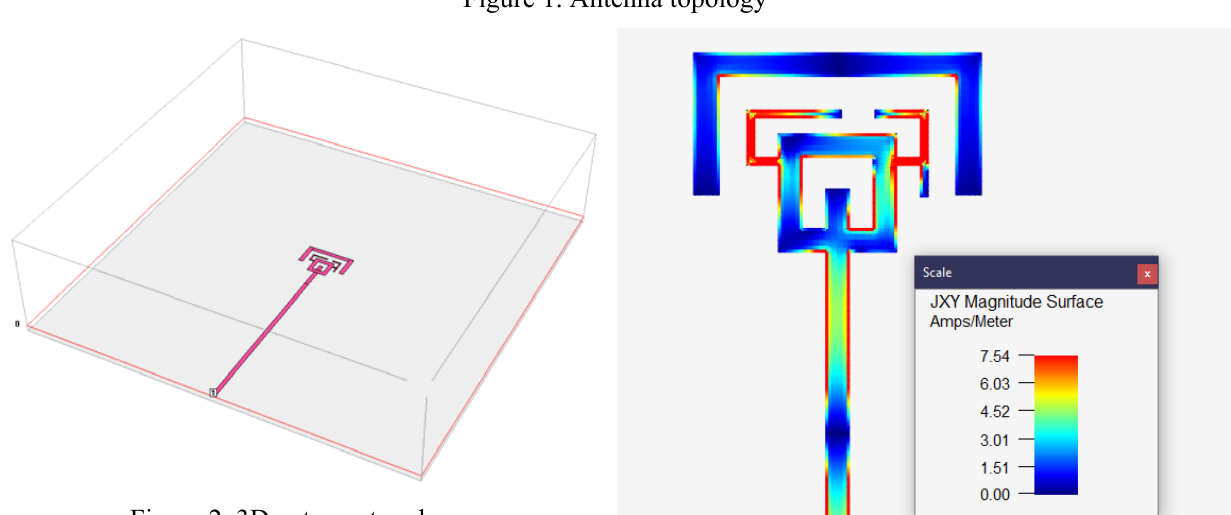
Figure 3. Current density